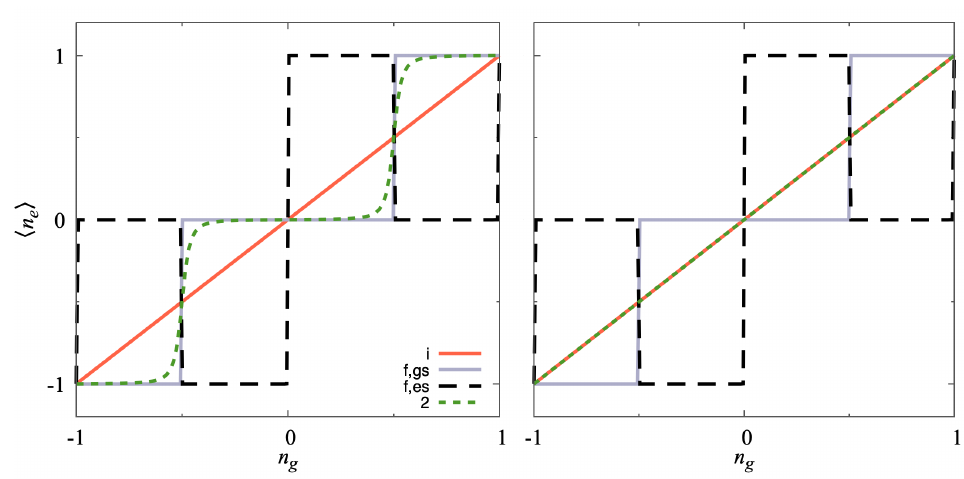
Figure 7: Average number of electrons in the island at i , f , and 2 steps (see Fig. 〉 in 1 is the same as 3), where gs and es denote the ground and excited states. 〈 n e (cid:29) E = E / 10 (b) and E max = 10 E in i for E . We show results for E max (a). J C C C M M = 100 E = E / 100, and E min = 10 − 6 E Here, E max , E min . The vertical axis has been C C C J J M 〉 = shifted such that the curves are centered at 〈 n e